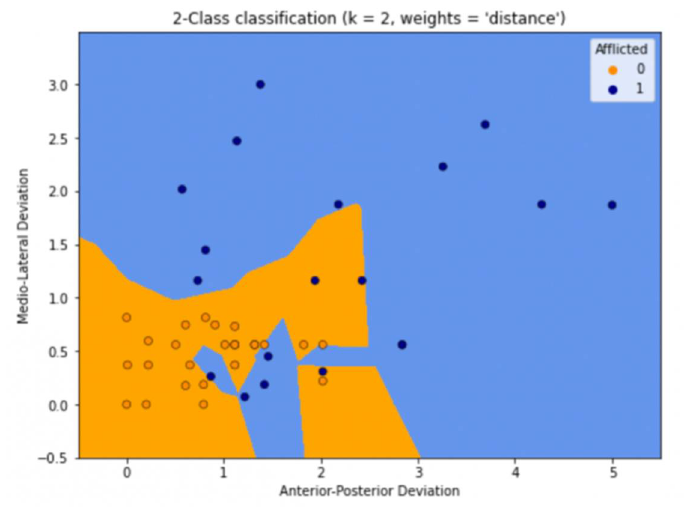
Figure 5. Prediction using K = 2.